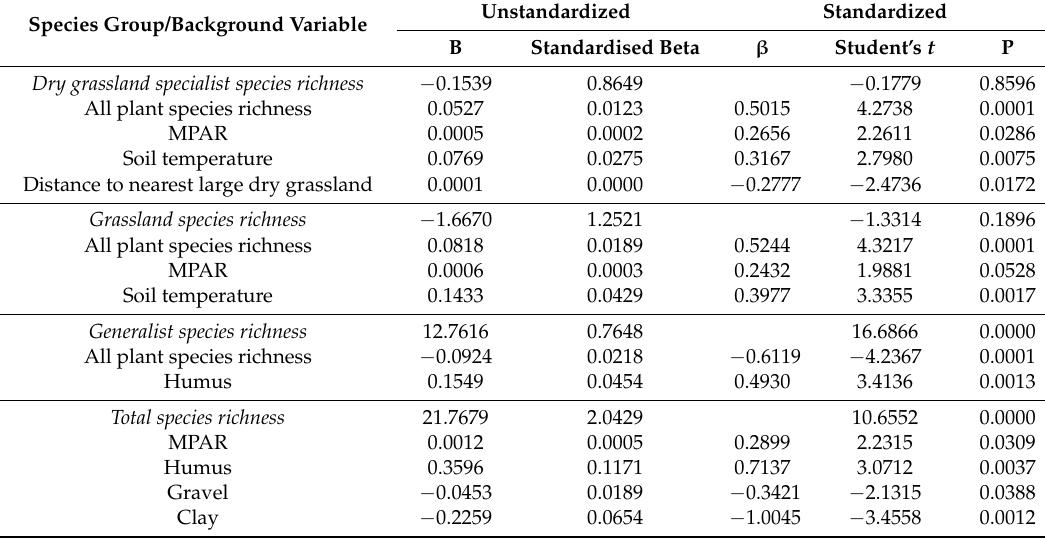
Table 4. Results from the significant multivariate regression models calculated with backwards elimination for several species richness measures of Collembola found in 50 dry grassland sites in Eastern